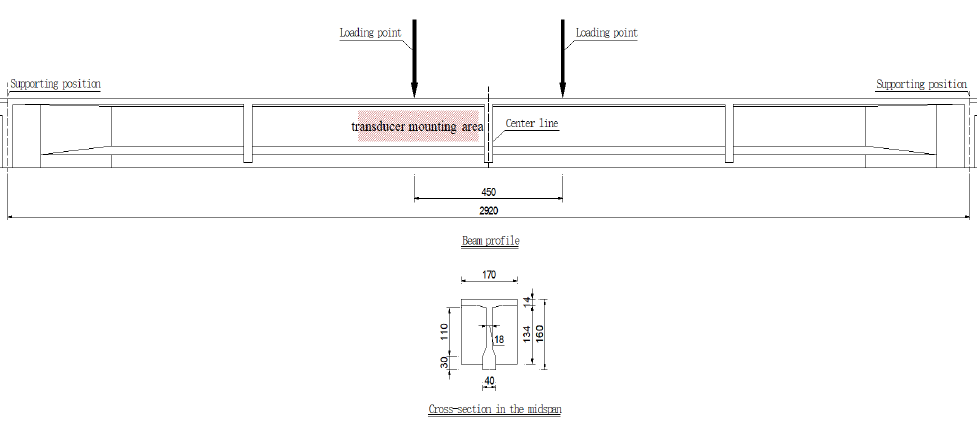
Figure 4. The front and right views of the concrete T-beam (unit: